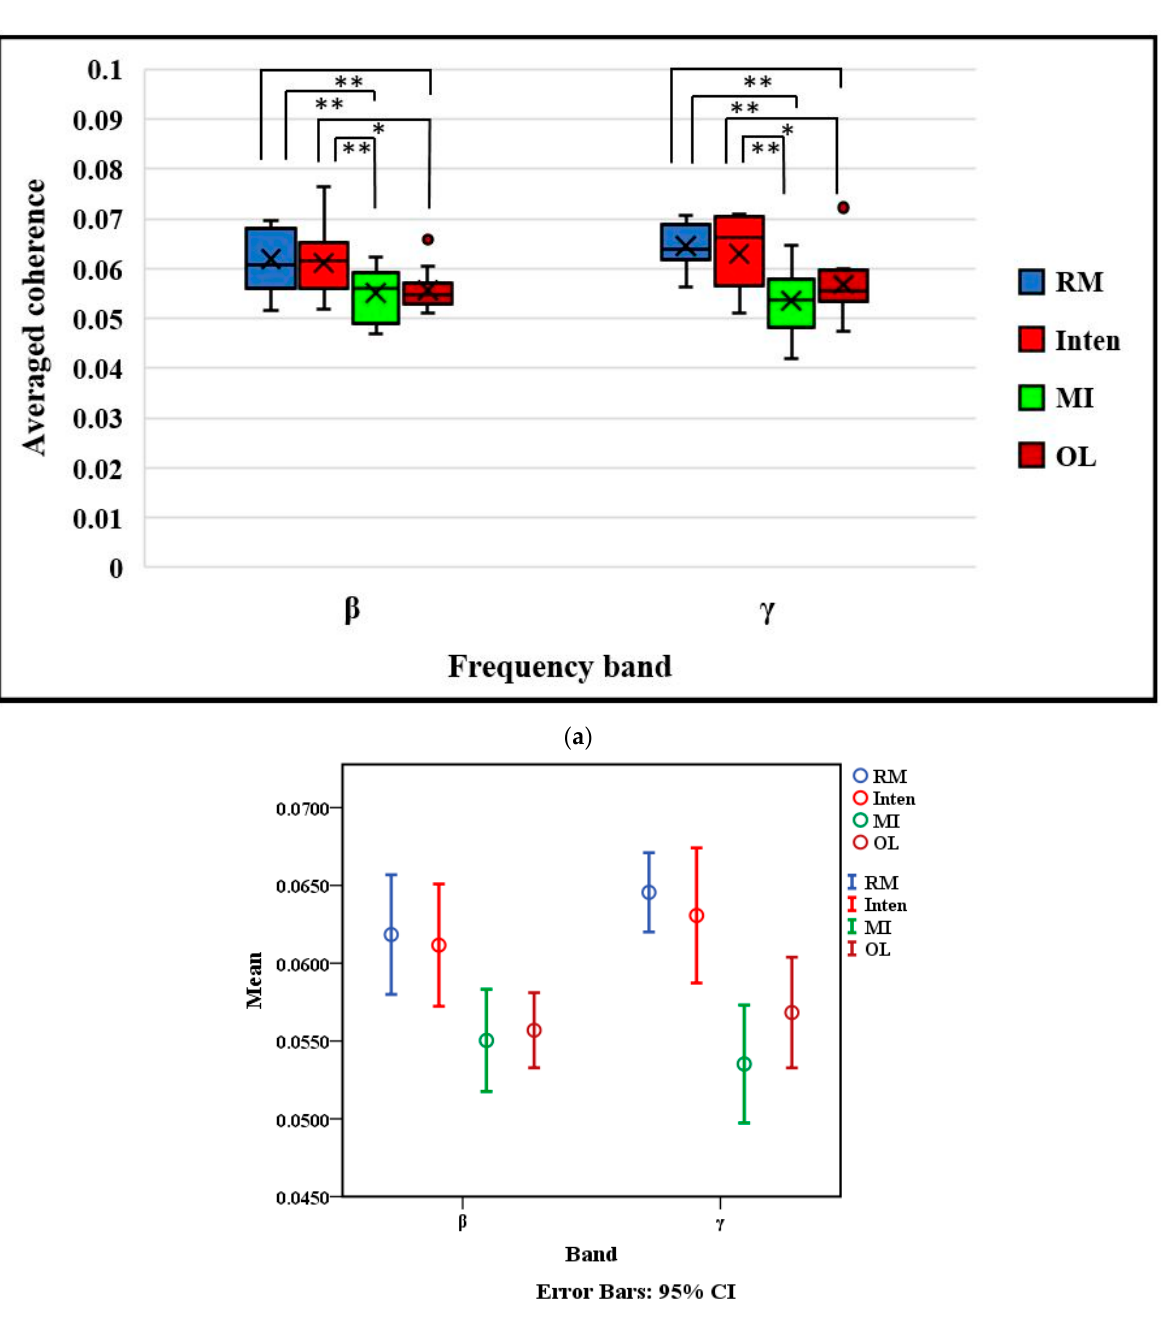
Figure 6. Comparison of the averaged coherence in beta band and gamma band based on motor tasks: ( a ) The top and bottom of each box represent the 25th and 75th percentiles, respectively. Cross sign inside each box represents the mean value. The horizontal black line represents the median. The whiskers are drawn from the ends of the interquartile ranges to the minimum and maximum values. * p < 0.05, ** p < 0.01. ( b ) Circle marked points represent the means and bars of these points represent the 95% CI of the within-subject standard error.